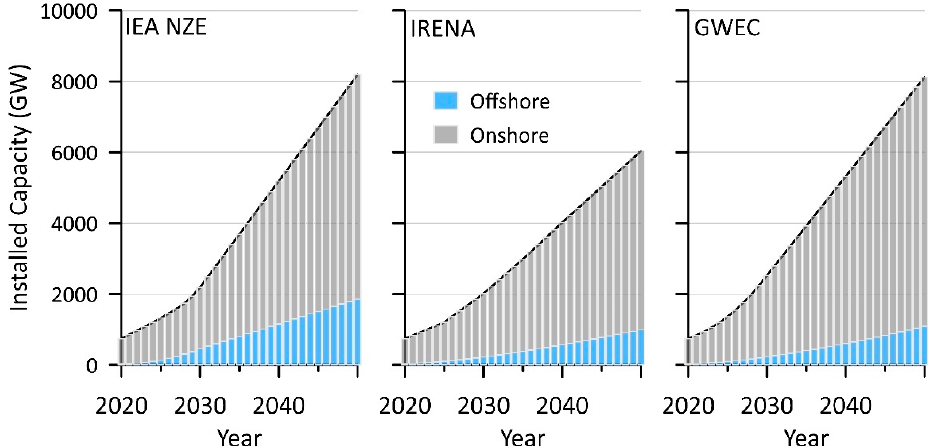
Figure 4. Global scenarios for the growth of wind energy IC. Data estimated from IEA NZE [14], IRENA [27] and GWEC [11,16]. The solid black line shows total wind energy IC while offshore IC is shown by the blue bars and onshore IC by the grey bars.